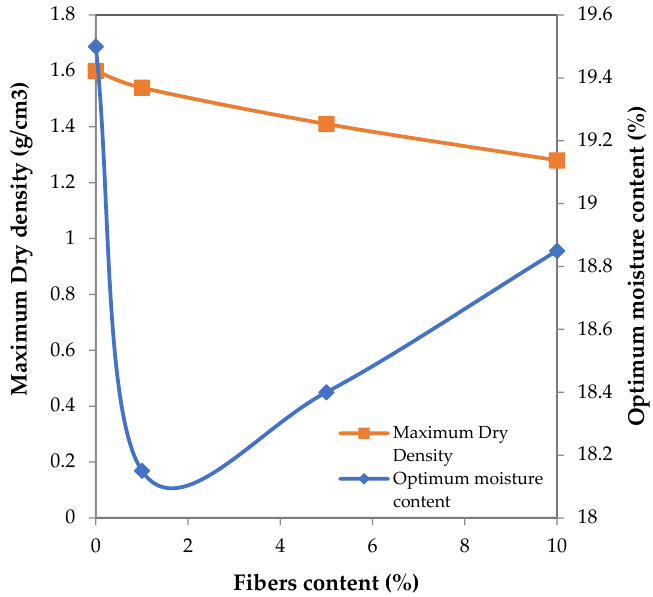
Figure 10. Variation of compaction characteristics as a function of the Diss fibers percentage.